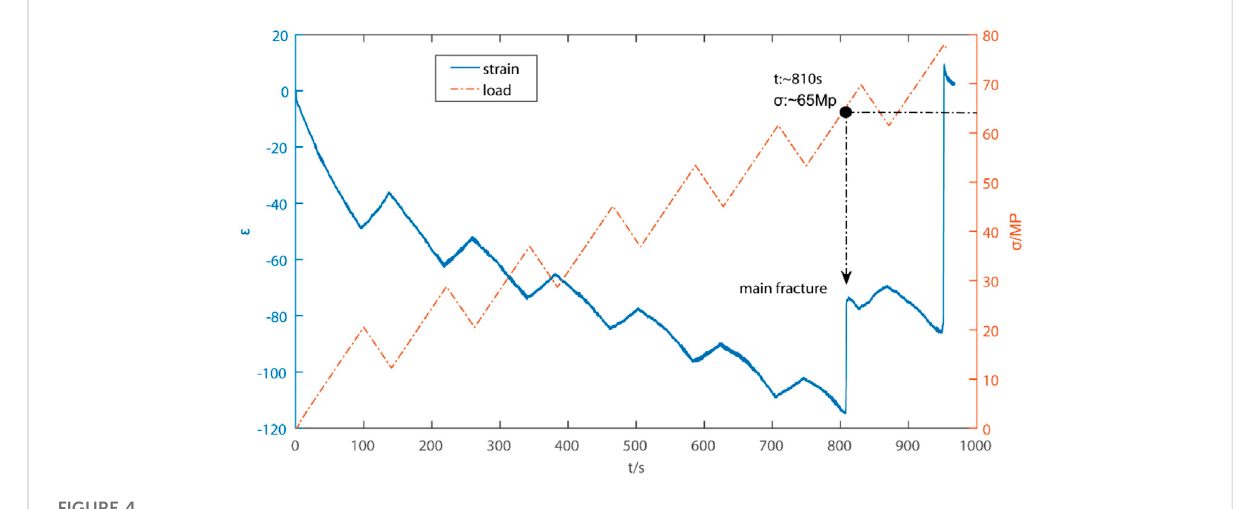
FIGURE 4 Strain-stress